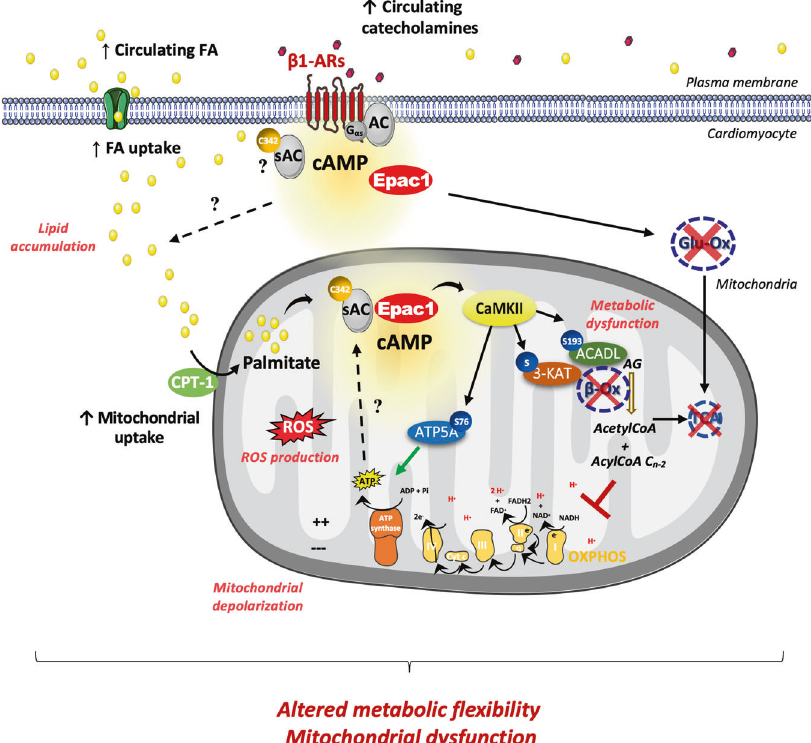
Fig. 7 Schema illustrating a working hypothesis of Epac1 signaling during metabolic stress. In the setting of a metabolic stress, circulating levels of FA and catecholamines are increased and promote FA uptake inside the cardiomyocyte. Palmitate positively regulates Epac1 activity by soluble adenylyl cyclase (sAC) palmitoylation. Epac1 dysregulates FA metabolism (mitochondrial uptake and β -ox) via the regulation of CPT- 1, β -ox enzymes, and ATP synthase by CaMKII δ -dependent phosphorylation. Thus, Epac1 disrupts the balance between the mitochondria uptake of FA and its consumption leading to accumulation of lipid intermediates, metabolic dysfunctions (ROS production, cell death, lipid accumulation, decreased oxidative metabolism), lipotoxicity, thereby affecting metabolic fl exibility and cardiac functions. Epac1 exchange protein directly activated by cAMP, FA fatty acid, cAMP cyclic AMP, CaMKII Ca 2 + /calmodulin-dependent protein kinase II, β 1-ARs β 1-adrenergic cardiac receptors, β -ox β -oxidation, Glu-ox glucose oxidation, CPT-1 cartinine palmitoyltransferase, ATP5A α subunit of ATP synthase, ACADL long-chain fatty acid acyl-CoA dehydrogenase, 3-KAT 3-ketoacyl-CoA thiolase, TCA tricarboxylic acid cycle, OXPHOS mitochondrial oxidative